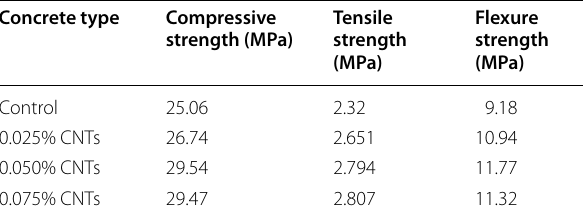
Table 4 Compressive, tensile, and flexure strength of concrete specimens